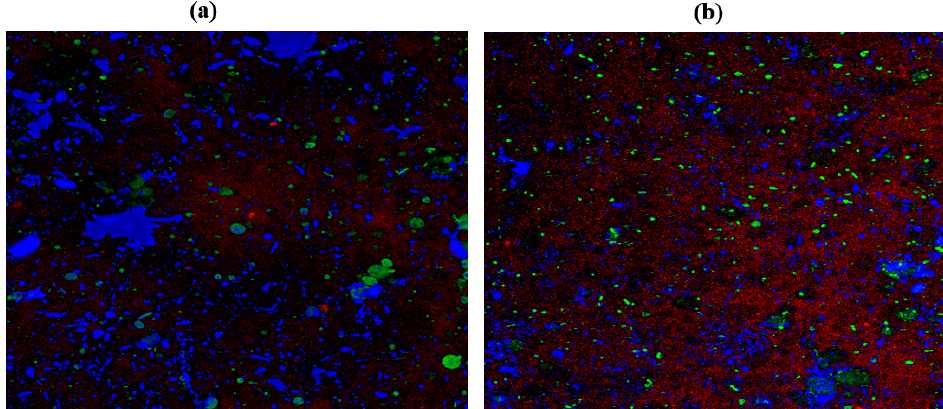
Figure 7. 3D resolution images of whole AGE ‐ treated (1 mg) C. albicans M207 using CLSM at ( a ) 12 h; ( b ) 24 h. All images were captured at 40× magnification under oil immersion.